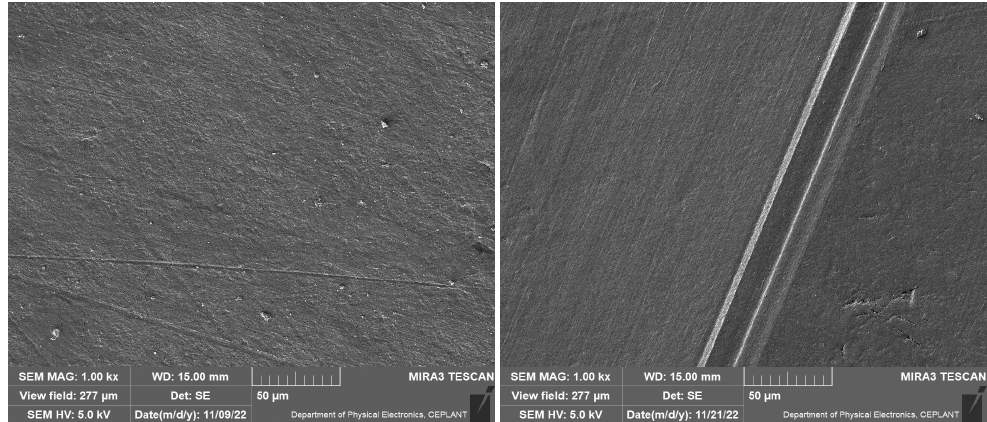
Figure 1. SEM image of PB thin film deposited at the monomer flow rate 35 sccm ( left image) and SEM image of bare teflon ( right image).